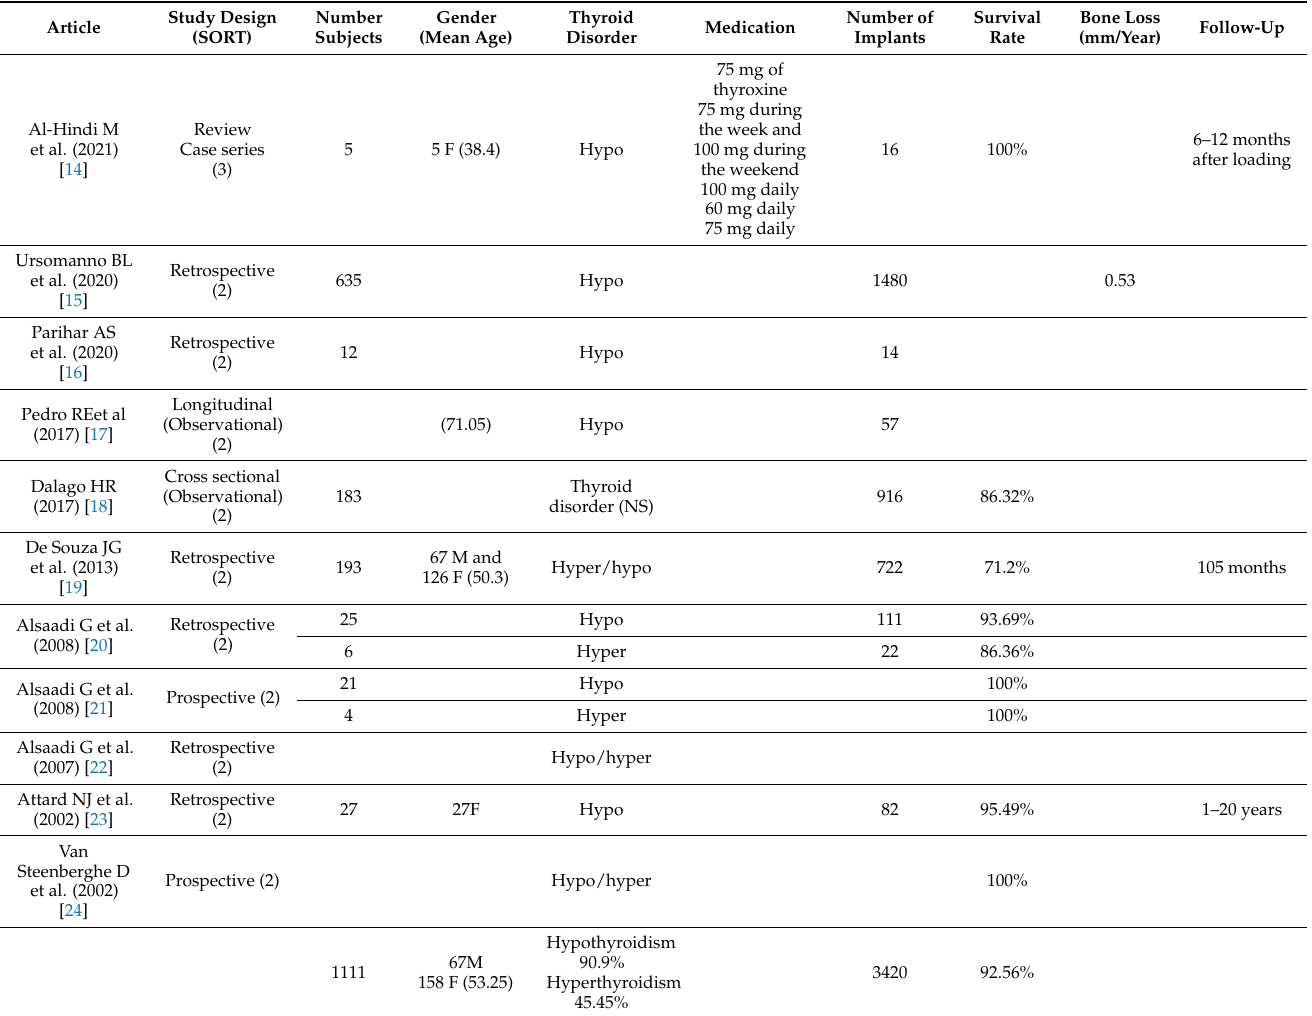
Table 1. Summary of the studies